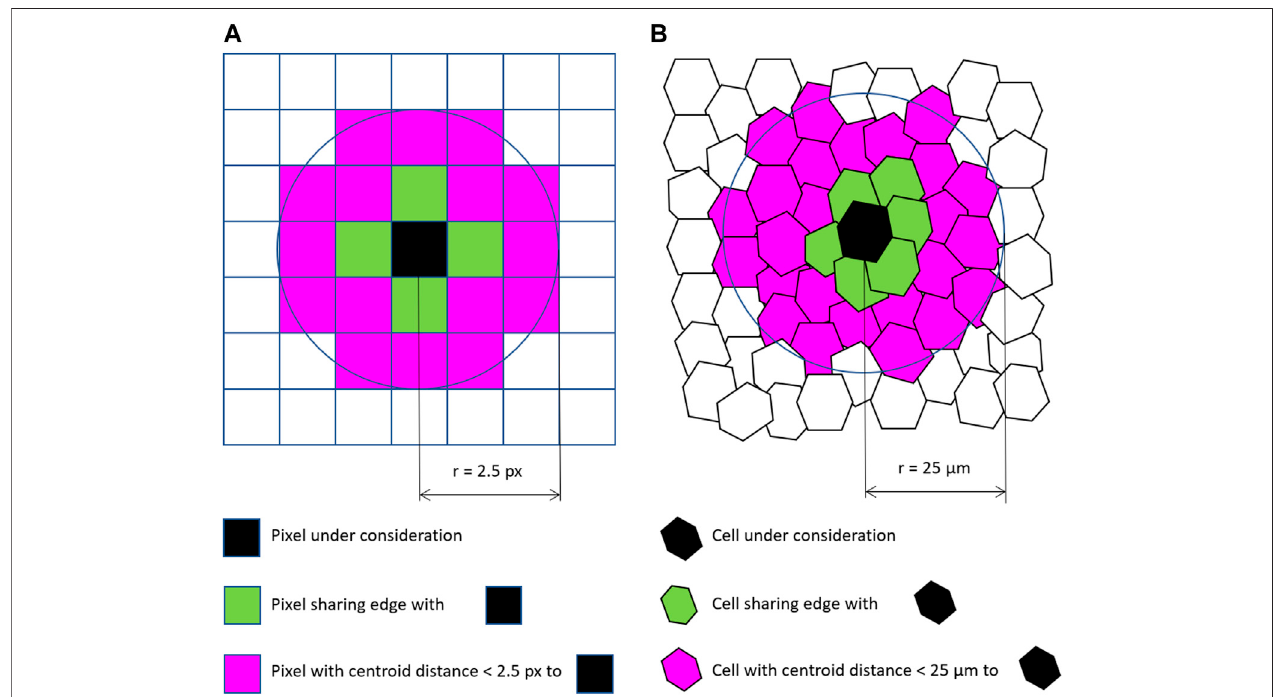
FIGURE 1 | Neighborhood relationships of pixels (A) and cells (B) : Pixels and cells sharing edges can be considered “ touching ” neighbors. Cells and pixels with a centroid distance below a given threshold can be considered “ proximal ” neighbors.